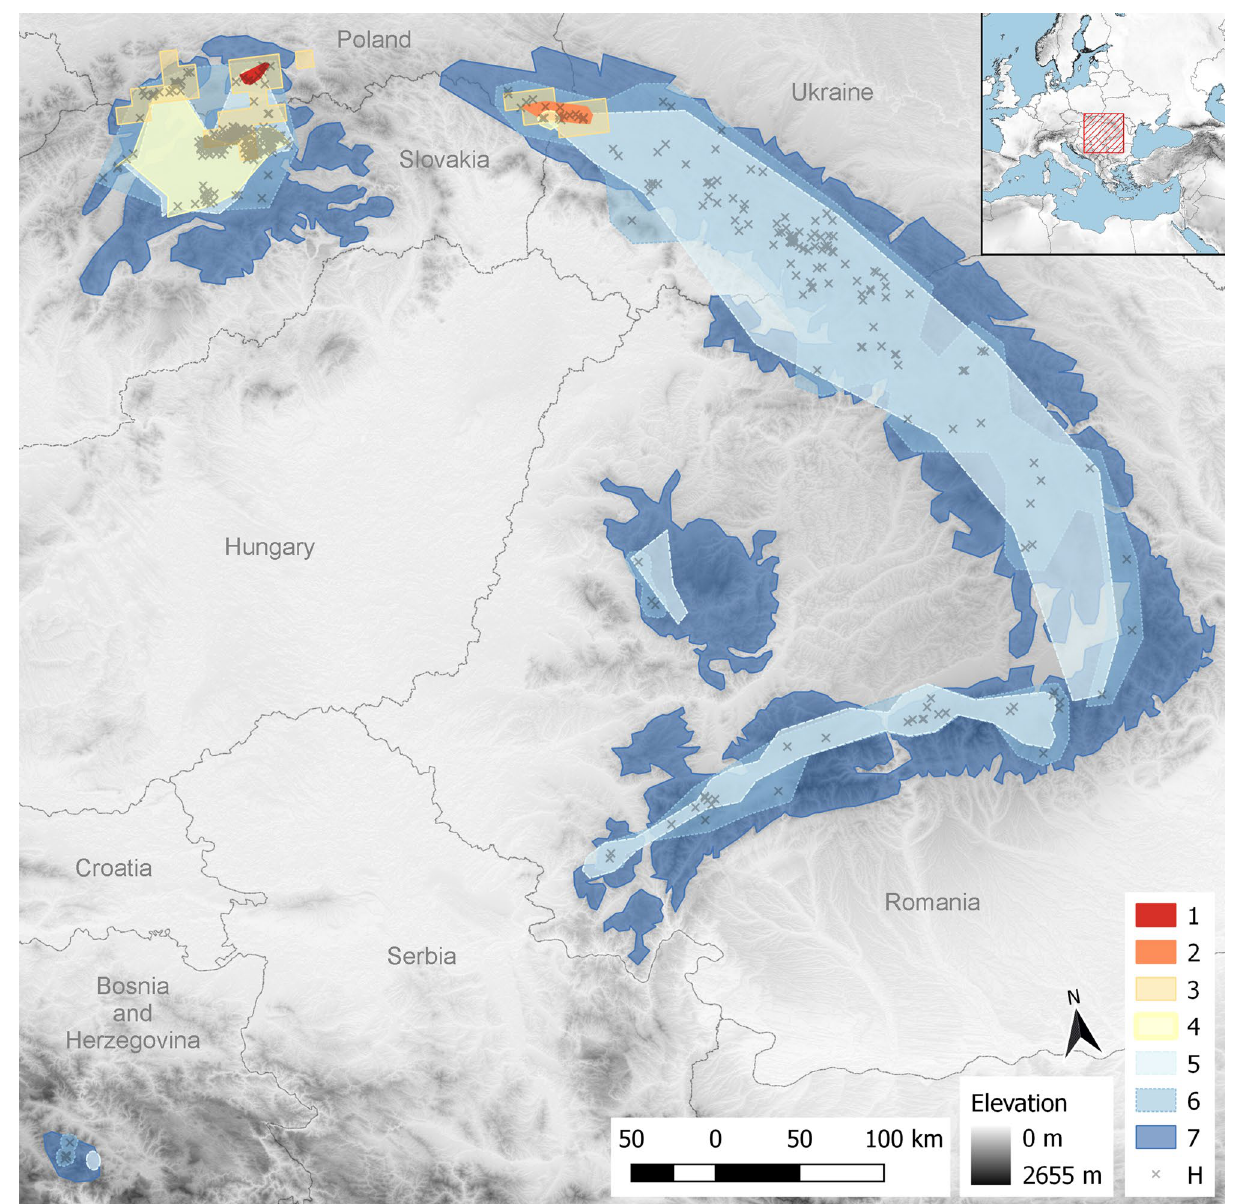
Figure 1. Extents of occurrence datasets used in this study: 1—Gorce Mts 30 , 2—Bieszczady Mts 31 , 3—Atpol quadrats 32 , 4—Slovakian occurrences 26 , 5—Carpathian occurrences 26 , 6—georeferenced herbarium material, 7—distribution in the Carpathians 33 . H (cross)—denotes herbarium localities and displays findings and sampling intensity. All shapes are constructed as convex hulls around points; only datasets 3 and 7 are polygons of species range. The red hatched area in the inset in the upper right corner shows the extent of the map. The underlying image represents the altitude derived from ALOS DEM dataset 34 . The map is projected in ETRS89 (EPSG: